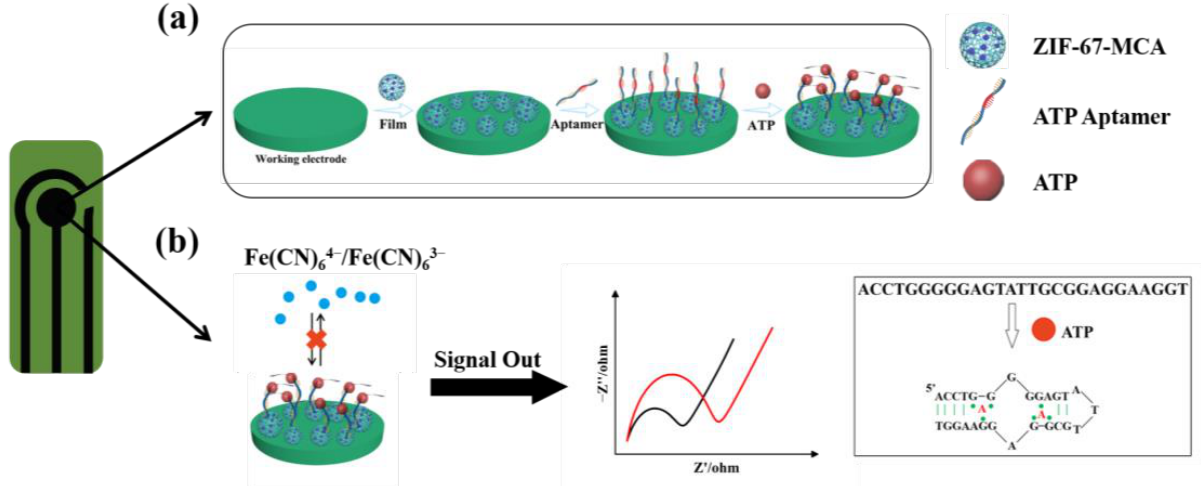
Figure 1. ( a ) Scheme of the process for the fabrication of ZM-based electrochemical aptasensor for detecting ATP; ( b ) principle of EIS measurement for detection and scheme of the conformational change by ATP binding with aptamer (the black line represents the initial R ct of the aptasensor , the red line represents the R ct of the aptasensor after the addition of ATP).